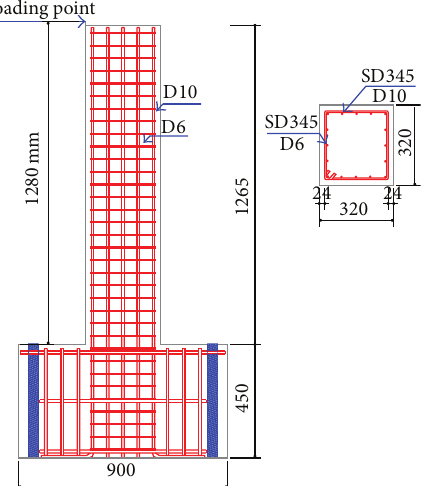
Figure 3: Experimental setup and geometrical properties of RC